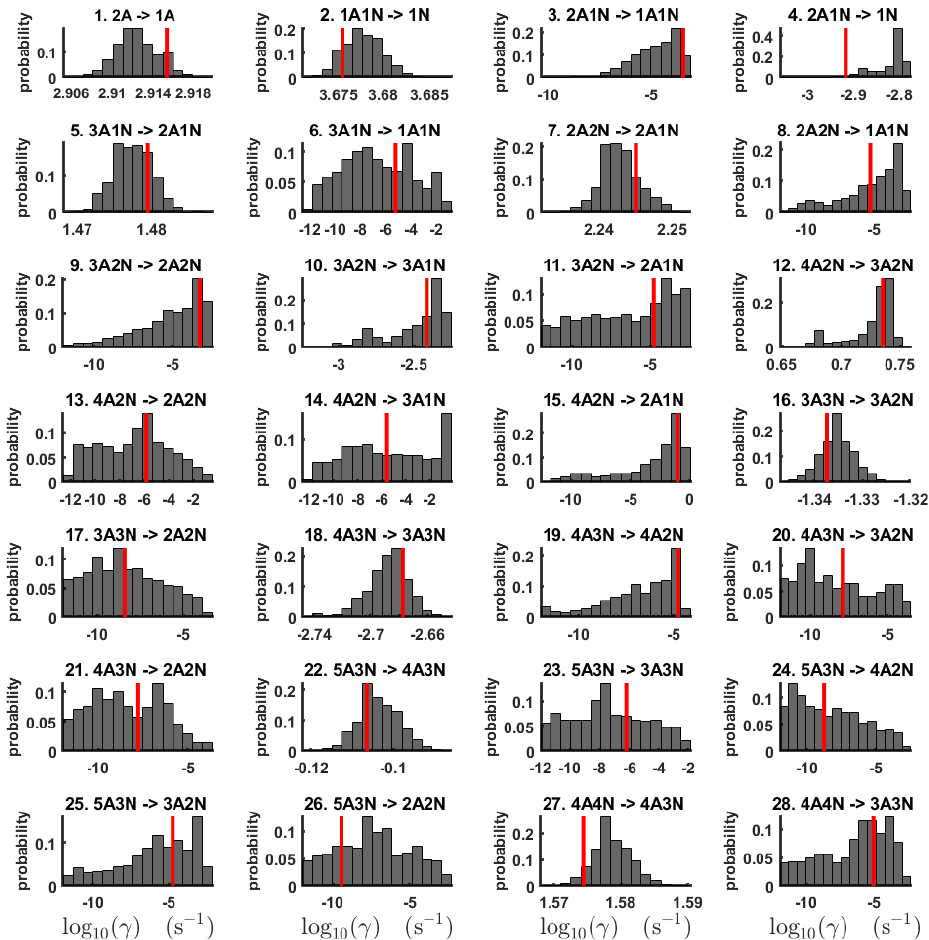
Figure 3. One-dimensional marginal posterior distributions (for parameter indexes ranging from 1 to 28) of the base 10 logarithm of the evaporation rates (units given in s − 1 ) determined from steady-state cluster concentration measurements at the temperature 278K. Red lines denote the baseline values from Olenius et al. (2013b) used to generate the synthetic data. The notation xAyN corresponds to a cluster with x sulfuric acid and y ammonia